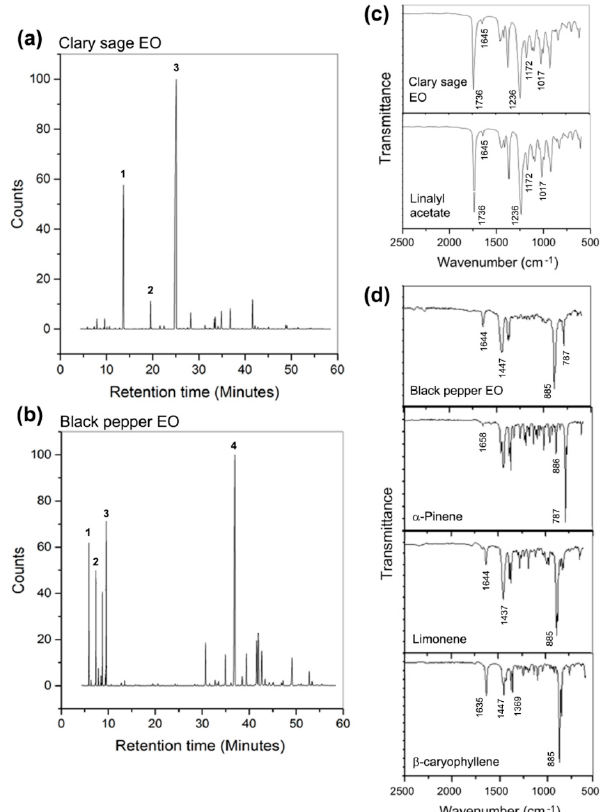
Figure 2. ( a ) Chromatogram of clary sage EO, where 1: linalool, 2: terpineol, 3: linalyl acetate; ( b ) Chromatogram of black pepper EO, where 1: α -pinene, 2: β -pinene, 3: limonene, 4: β -caryophyllene; ( c ) FTIR spectra of pure clary sage EO and linalyl acetate; ( d ) FTIR spectra of pure black pepper EO, α -pinene, limonene and β -caryophyllene .